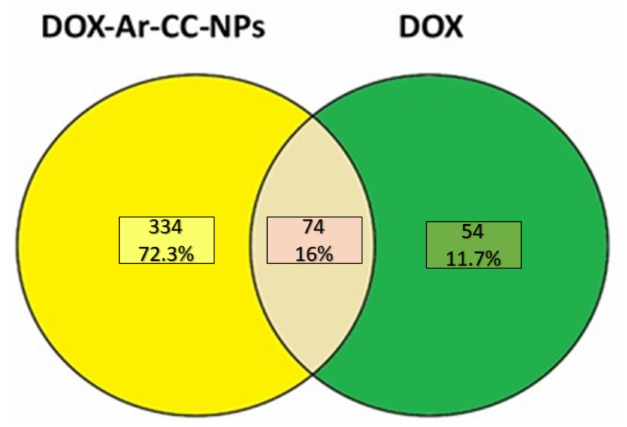
Figure 7. Venn diagram depicting the comparison of proteins identified in DOX-Ar-CC-NPs and DOX- treated MCF-7 cells (breast cancer cells). The overlap represents 74 proteins whose expressions are significantly correlated ( p < 0.00001) statistical significances differences were estimated by ANOVA.